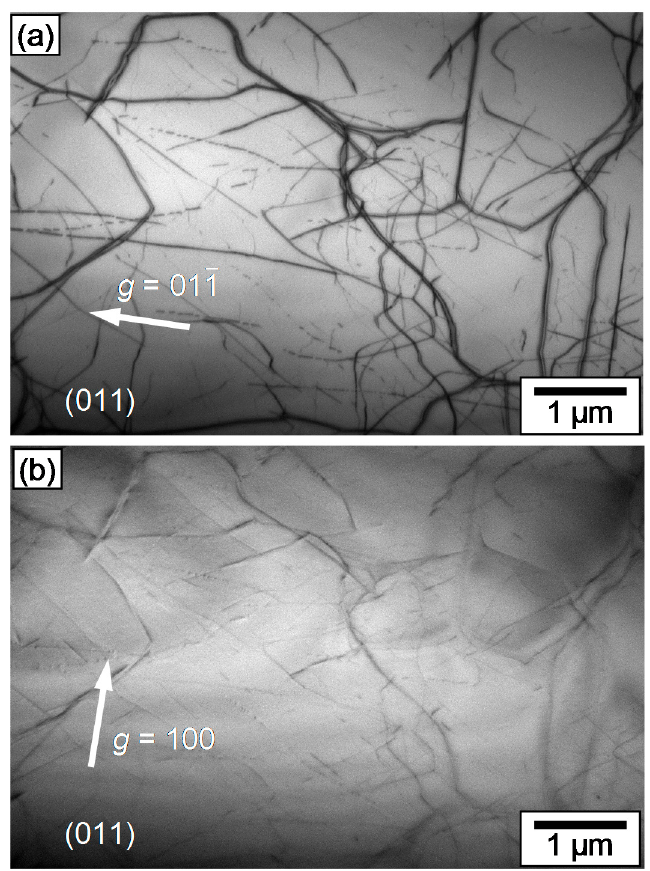
Figure 4. Typical TEM bright field images taken from the Sr / Ti = 1.04 specimen deformed at ε = 1.0 × 10 − 1 (s − 1 ) up to ε p = 3%. The image in ( b ) was obtained from the same field as in ( a ) using a different diffraction vector.